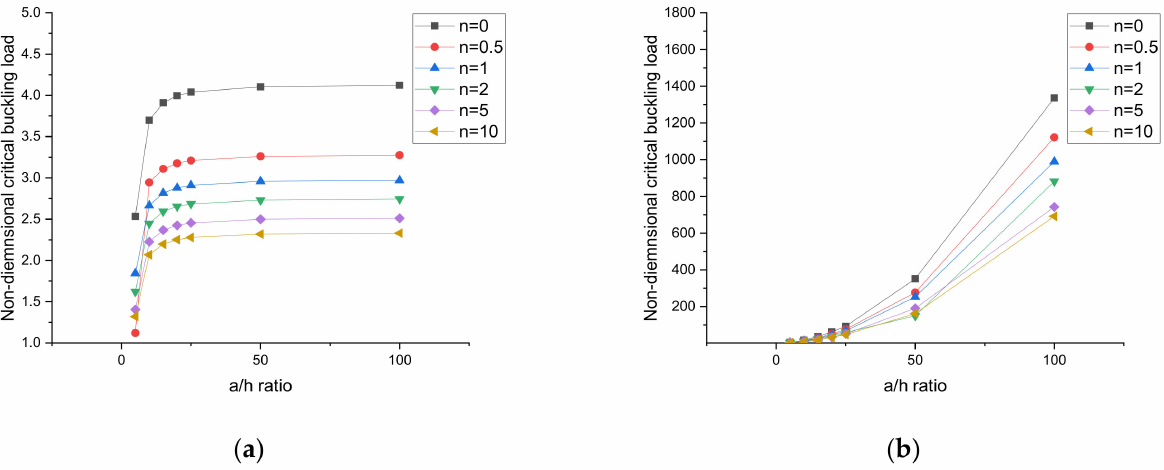
Figure 9. Variation of the buckling load under biaxial compression. ( a ) SSSS, ( b )